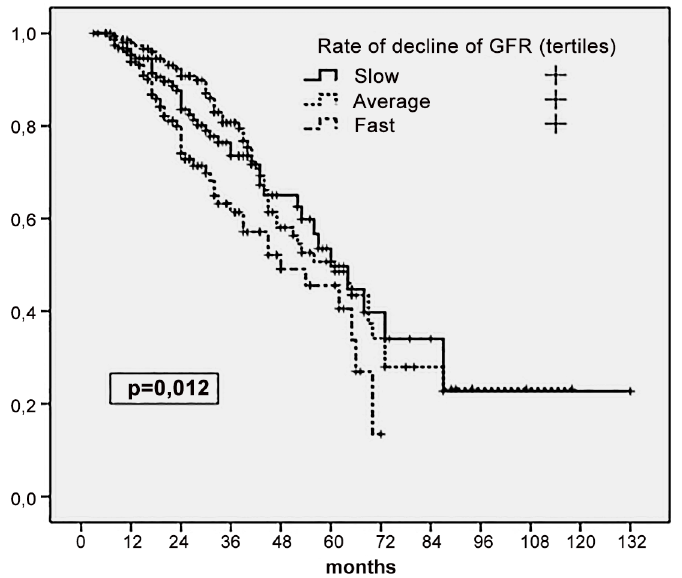
Fig 3. Patient survival according to tertiles of the rate of decline of GFR during follow-up. Kaplan Meier plot (log rank).